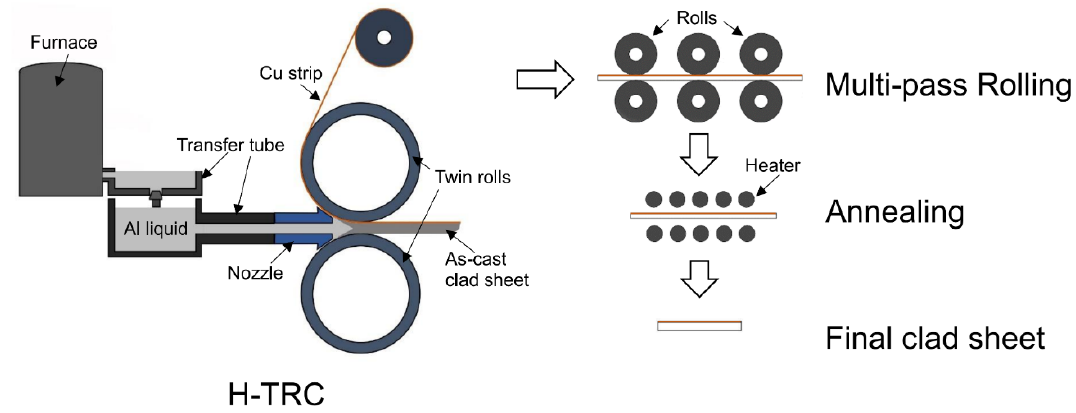
Figure 1. Schematic illustration of the fabrication process for Cu/Al clad sheet.